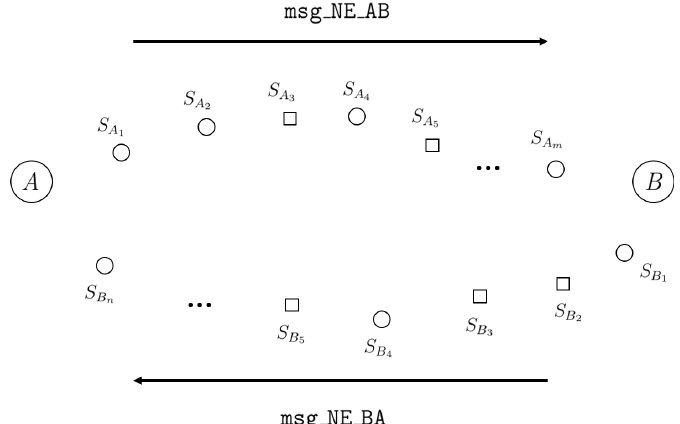
Figure 1. Two possible routes connecting Alice ( A ) and Bob ( B ). Circular and rectangular nodes represent quantum and classical switches,